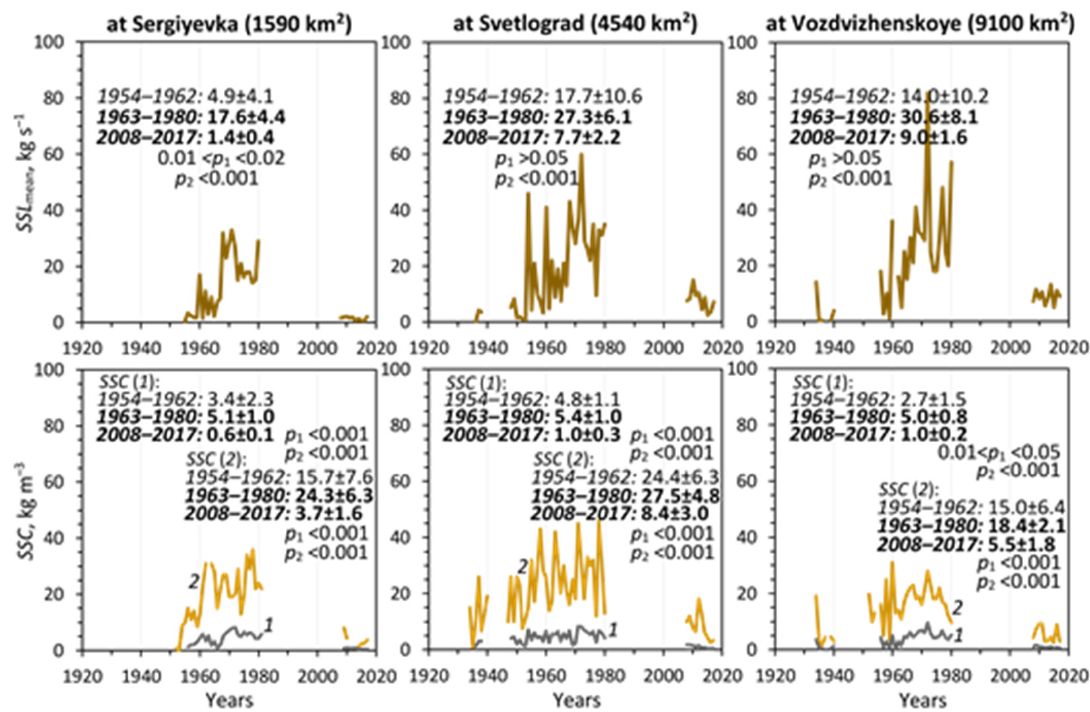
Figure 6. Contemporary long-term changes in mean annual suspended sediment load ( SSL mean ) and suspended sediment concentration ( SSC ) of the Kalaus River at the analyzed hydrological stations (see Figure 1; Table 1). SSC ( 1 ) — averaged maximal (per annum) SSC ; SSC ( 2 ) — averaged mean annual SSC ; p 1 —the probability of statistically significant difference between 1954–1962 and 2008–2017; p 2 —the same between 1963–1980 and 2008–2017 (the Student’s t -test).